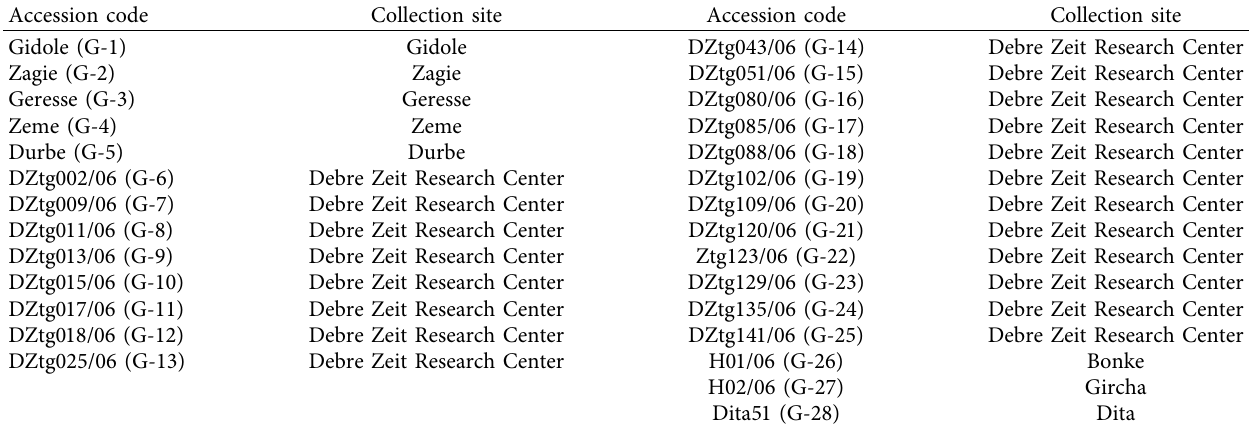
Table 1: Description of the garlic germplasm included in the study, Gamo highlands, southern Ethiopia,